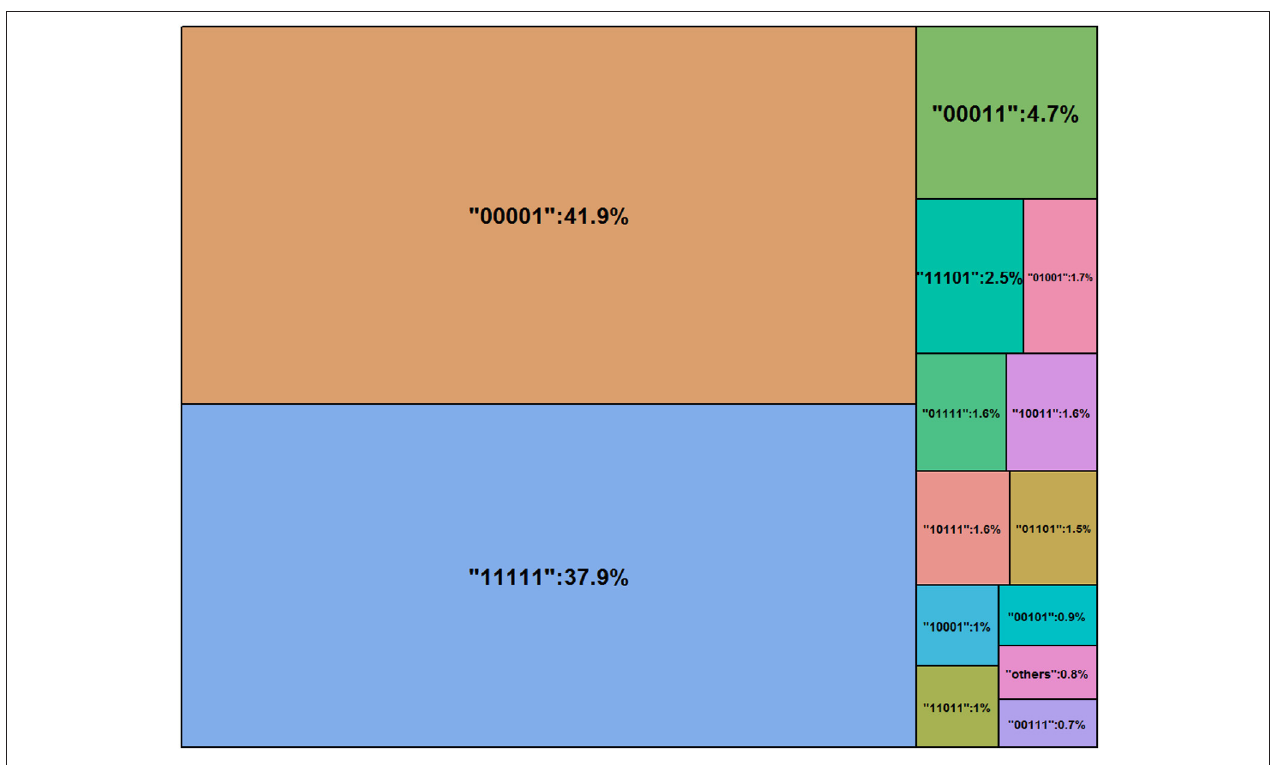
FIGURE 3 | Estimated class probabilities via LCDM.